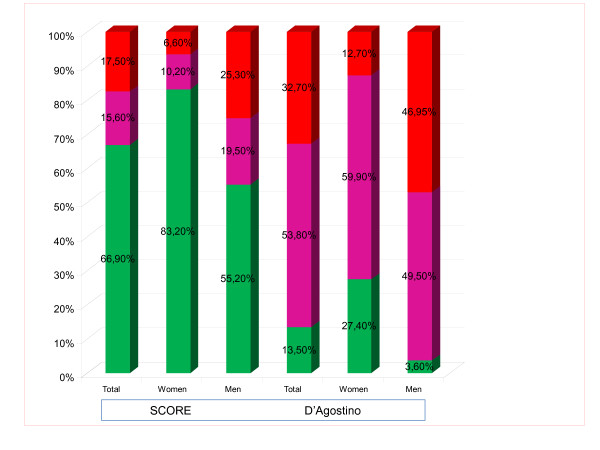
Distribution (in percentages) of the population in risk categories, overall and by sex, in the D'AGOSTINO and SCORE functions.